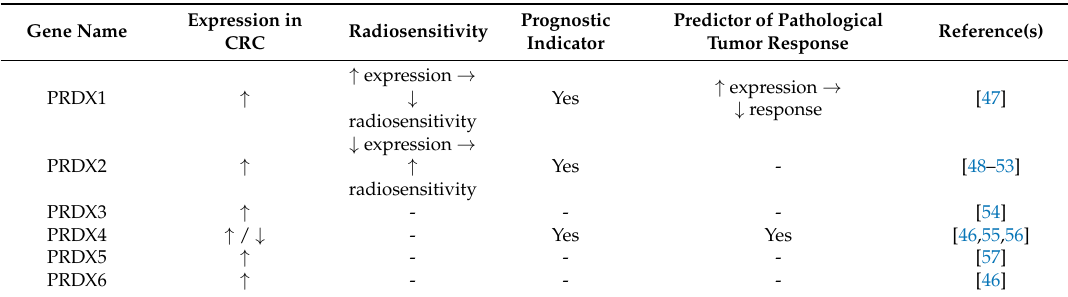
Table 1. Peroxiredoxin expression and associations with radiosensitivity and prognosis of colorectal